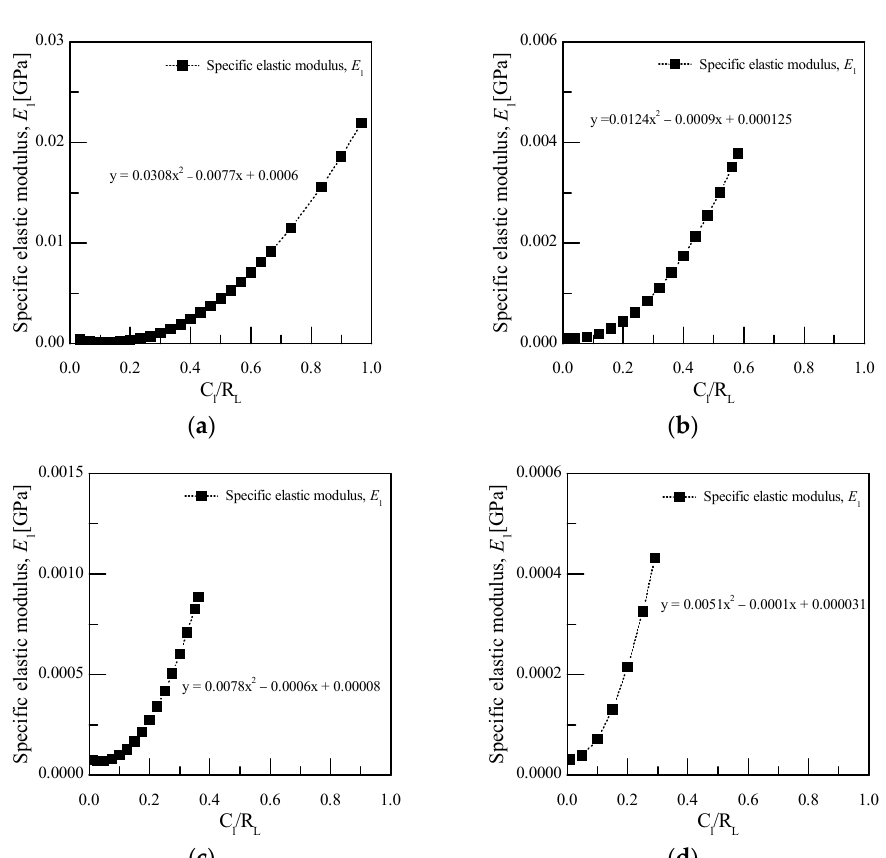
Figure 7. Changes in the effective properties of a CNT inside an RVE according to an RVE length of ( a ) 3, ( b ) 5, ( c ) 8, and ( d ) 10 µ m